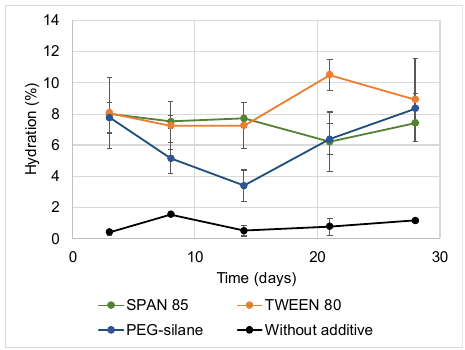
Figure 3. Hydration of paints during immersion measured by Karl Fisher Titration.